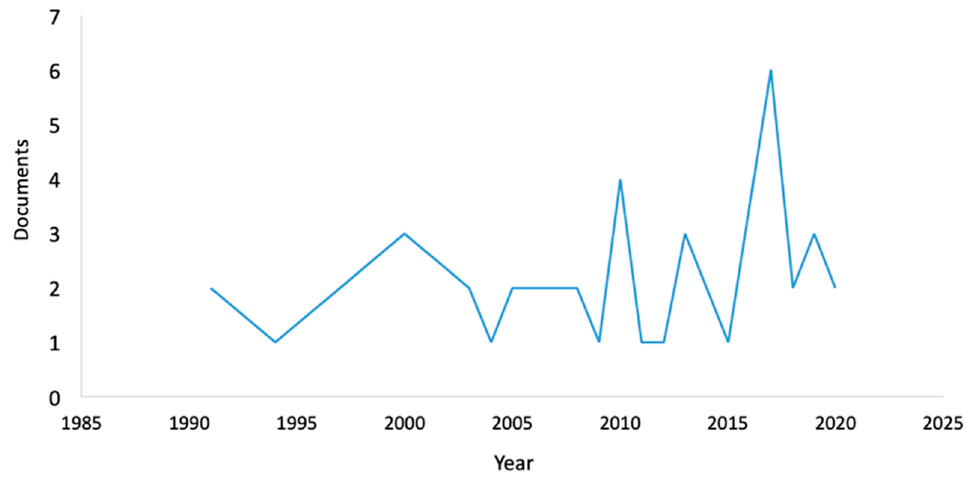
Figure 1. Documents by year (source: own authorship).